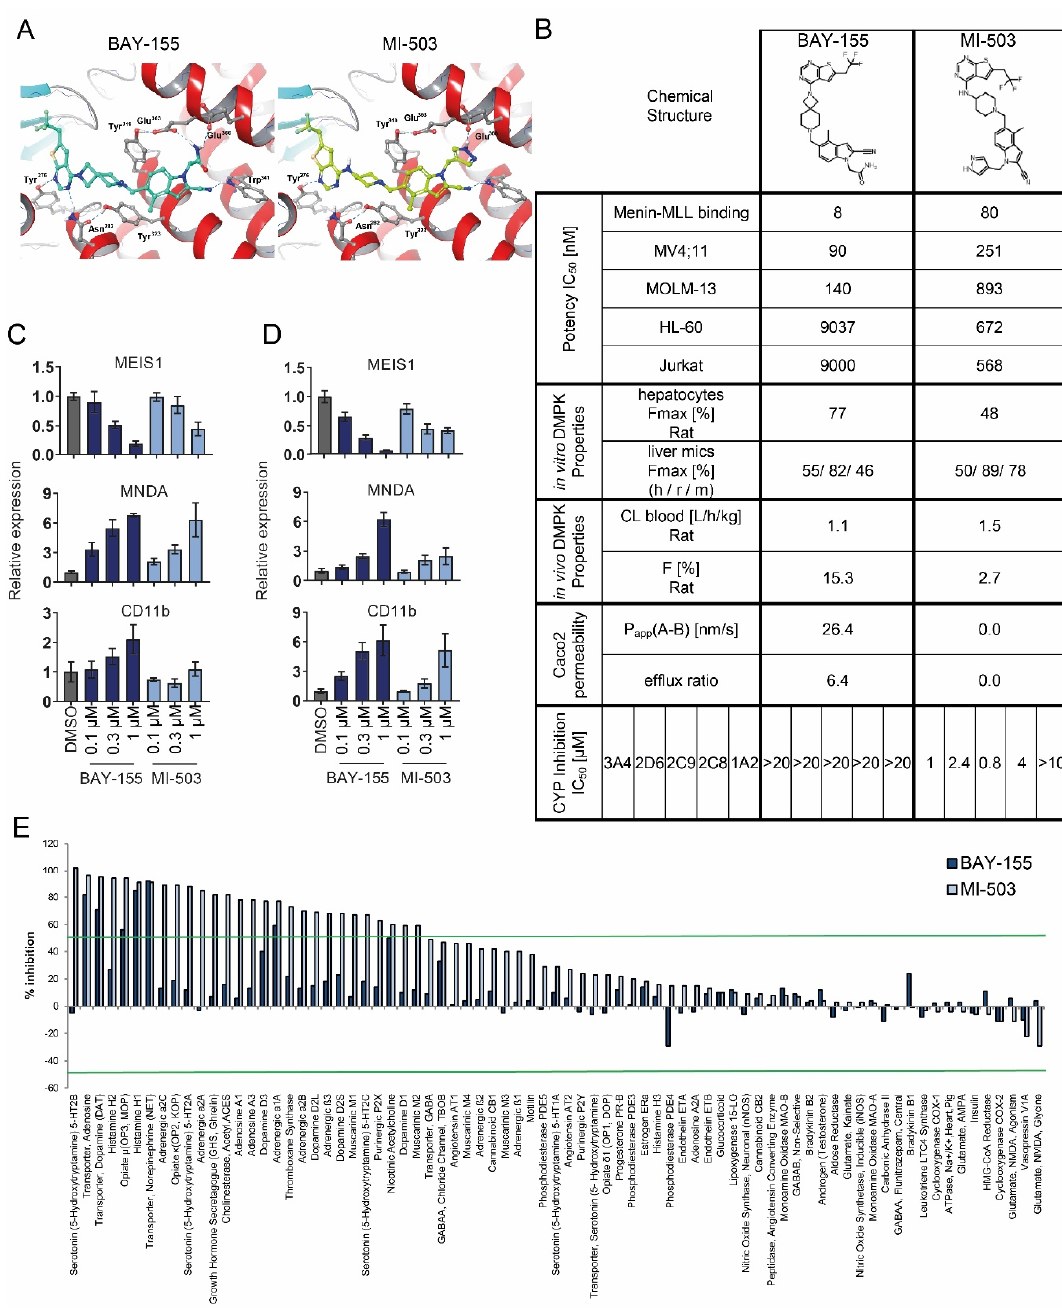
Figure 1. Pharmacological activity and selectivity of the menin-MLL inhibitors BAY-155 and MI-503. ( A ) X-ray structure of menin in complex with compound MI-503 (4X5Y.pdb, right ) and with docked BAY-155 ( left ). In both binding mode representations, the rotamer of Asn282 has been adapted and taken from 4GQ3.pdb. ( B ) Characterization of drug-like properties of BAY-155 and MI-503. Data presented for BAY-155 have been previously reported [26]. ( C , D ) Relative qRT-PCR analysis of genes associated with hematopoietic di ff erentiation in MV4;11 ( C ) or MOLM-13 ( D ) cells after four days of treatment with BAY-155 or MI-503. Data presented are an average of three biological replicates normalized to vehicle control (DMSO). ( E ) Selectivity profile of BAY-155 and MI-503 in a panel of assays covering several safety pharmacology relevant proteins. Inhibitors were tested at a concentration of 10 µ M. Green lines indicate 50% of inhibition or activation relative to vehicle control (DMSO).